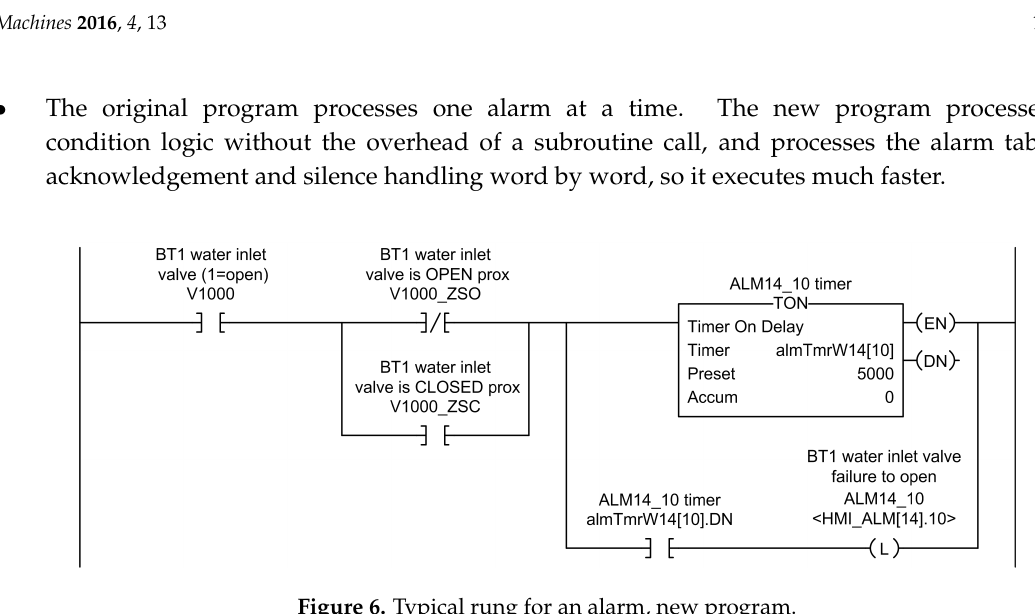
Figure 6. Typical rung for an alarm, new